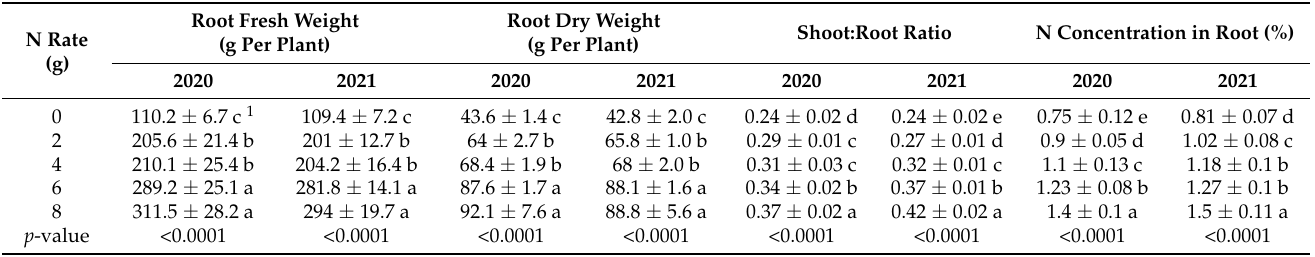
Table 3. Root fresh, dry weight, shoot: root ratio, and N concentration in root of plants receiving five N rates in 2020 and 2021.